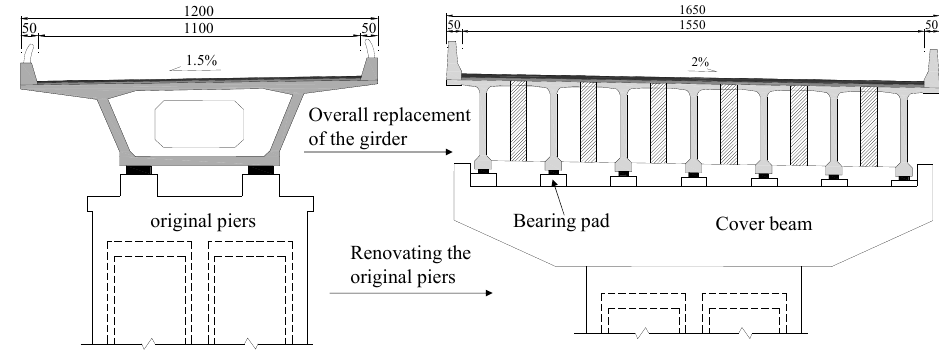
Figure 4. Overall replacement of the girder (unit: cm).